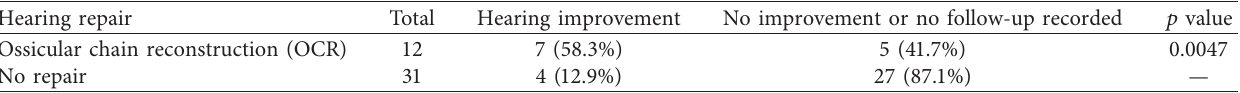
Table 3: Hearing repair